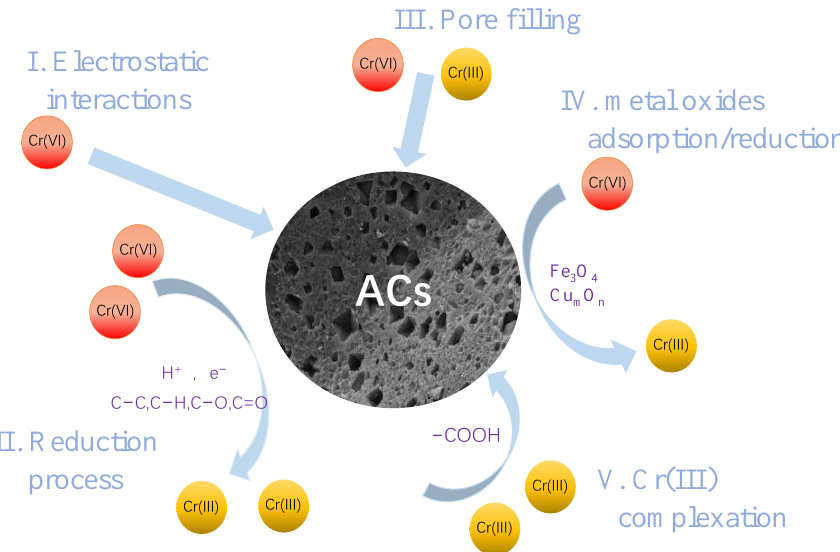
Figure 11. The adsorption mechanism of Cr( Ⅵ ) onto Zn − AC, Fe − AC, and Cu − AC.